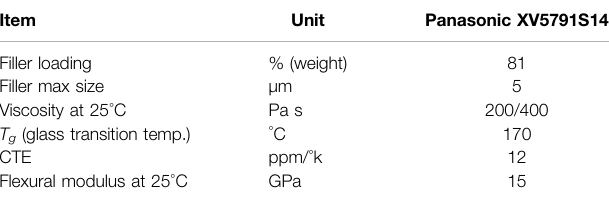
TABLE 2 | material parameters of the Panasonic XV5791S14 epoxy/amine